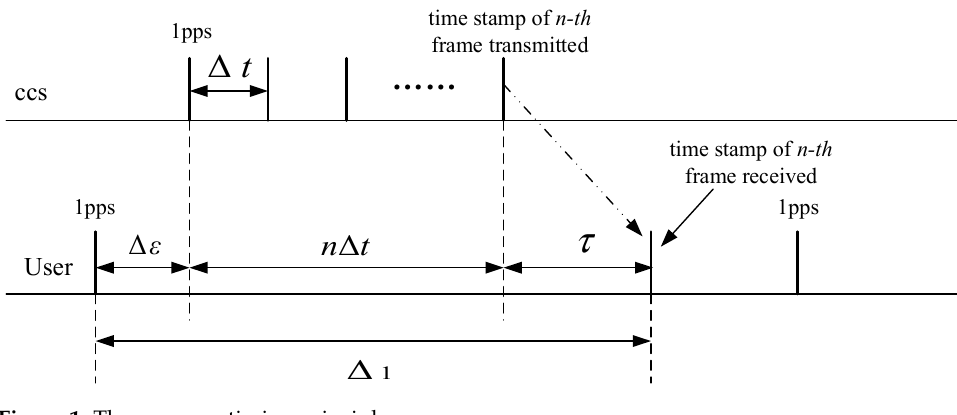
Figure 1. The one-way timing principle.